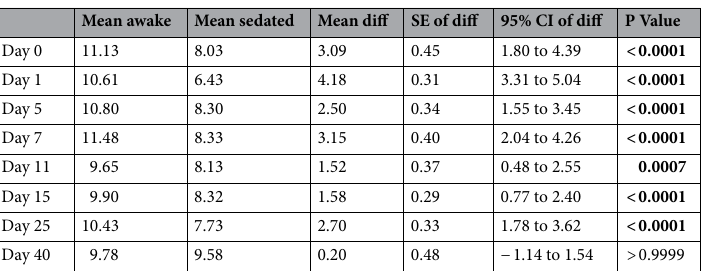
Table 3. Results of the two-way repeated measures ANOVA with Bonferroni correction, N = 21. CI, confidence